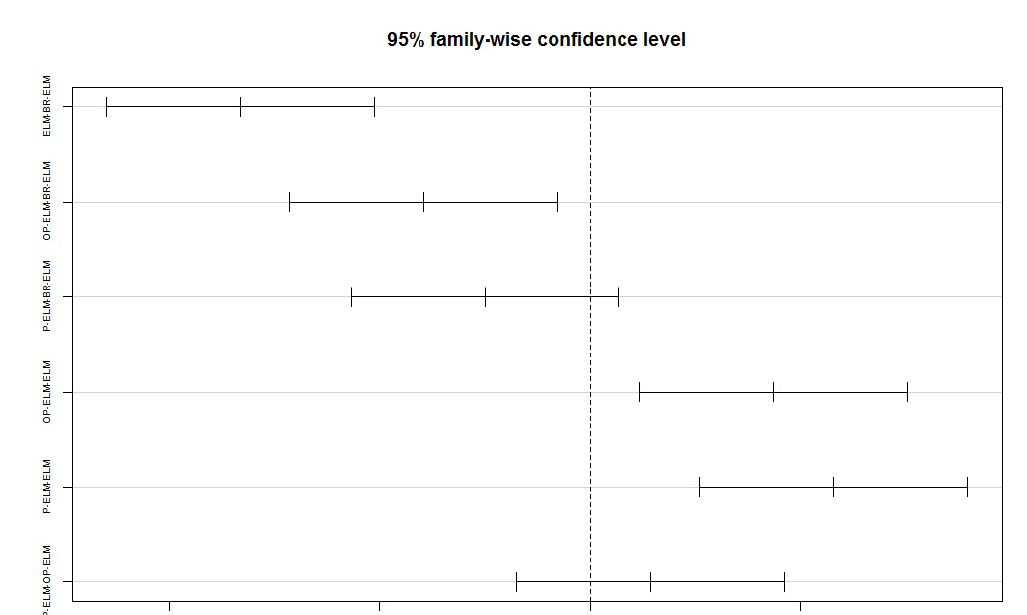
Figure 8. Multiple comparisons of